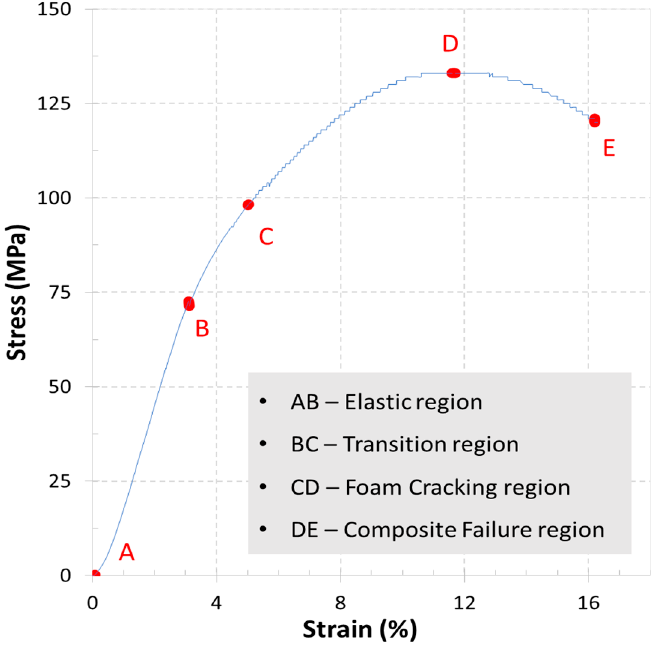
Figure 7. Compressive behavior of C4 ‐